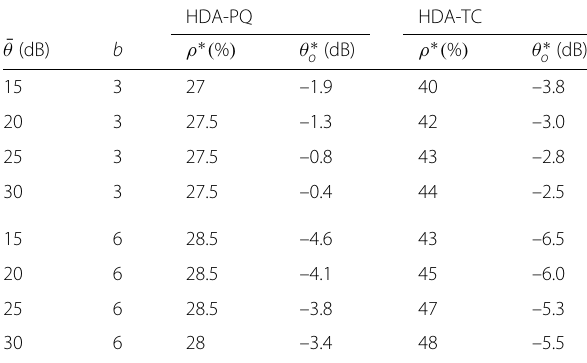
Table 1 The power allocations and outage CSNRs of HDA-PQ and HDA-TC systems shown in Fig.